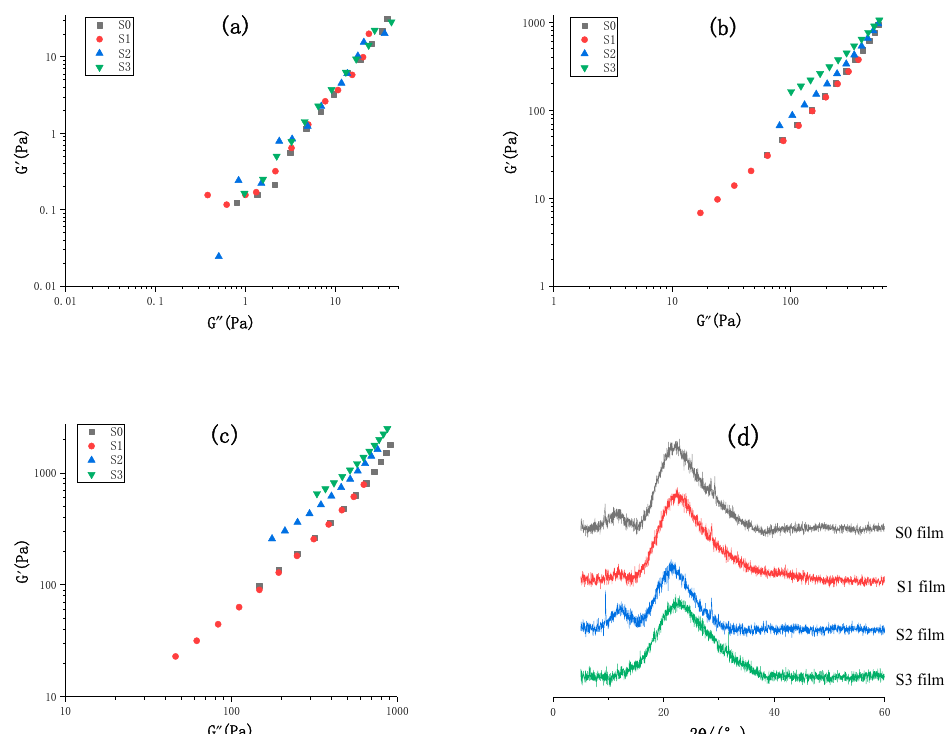
Figure 3. Han plots of the film-forming solutions dried to different water content ( a ) initial, ( b ) 90%, ( c ) 30%, ( d ) the XRD diffraction pattern of the S0–S3 film. The Han plots of S0-30, S0-90, and S1-30, S1-90 still overlapped well, respectively (Figure 3), indicating that they still had good compatibility. For S2-90, the slope of the Han plot was close to 2. However, the slope of the Han plot of S3-90 deviated from 2. This